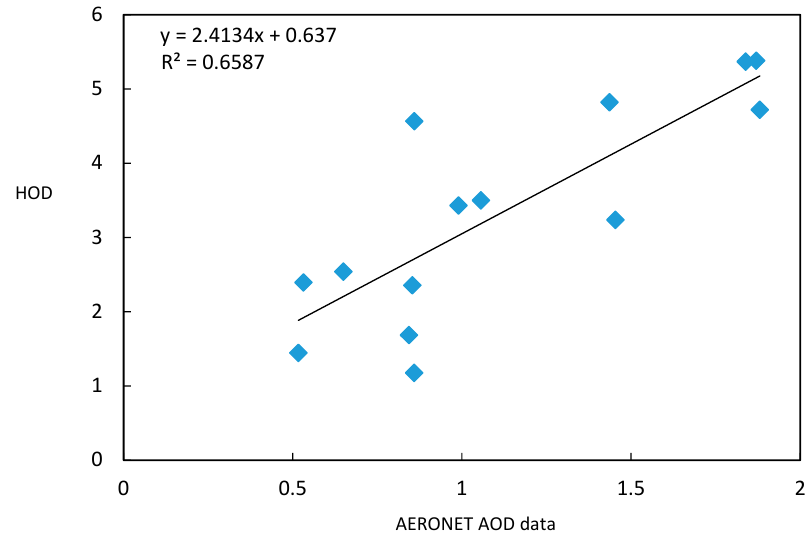
Figure 1. Validation of haze aerosol optical depth (HOD) with that from Beijing AERONET station.